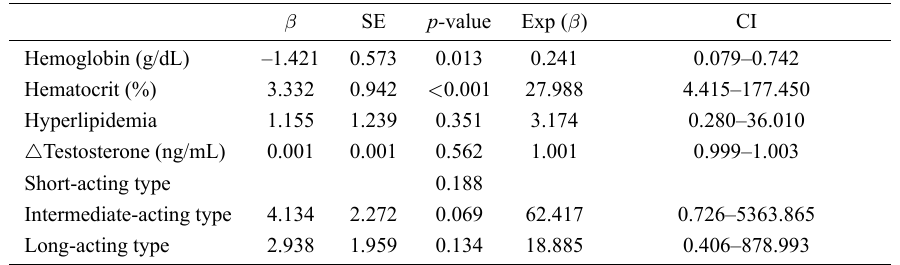
Table 6. Multivariate analysis results based logistic regression performed for evaluating clinical factors associated with